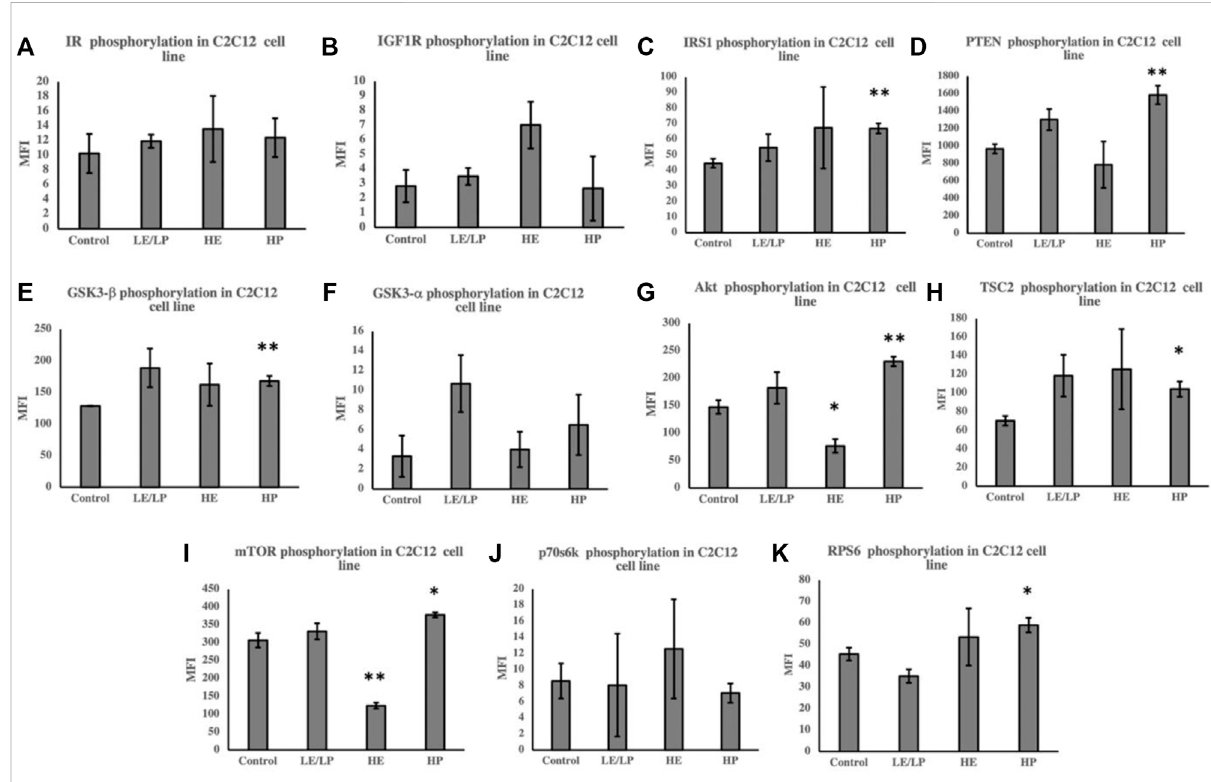
FIGURE 3 Effect ofincubatingC2C12 cells with 10%ofserafrom differentathletegroups (LE/LP: lowendurance/low power,HE:high endurance, and HP: high power) on the activation of insulin signaling phosphoproteins, including insulin resistance (IR) (A) , insulin-like growth factor 1 receptor (IGF-1R) (B) ,insulinreceptorsubstrate1(IRS-1) (C) ,phosphataseandtensinhomologdeletedonchromosome10(PTEN) (D) ,glycogensynthasekinase3beta (GSK3- β ) (E) , glycogen synthase kinase 3 alpha (GSK3- α ) (F) , protein kinase B (AKT) (G) , tuberous sclerosis complex 2 (TSC2) (H) , mammalian target of rapamycin (mTOR) (I) , ribosomal protein S6 kinase beta-1 (p70S6K) (J) , and ribosomal protein S6 (RPS6) (K) . Data are presented as mean ± SEM (* p ≤ 0.05, ** p ≤